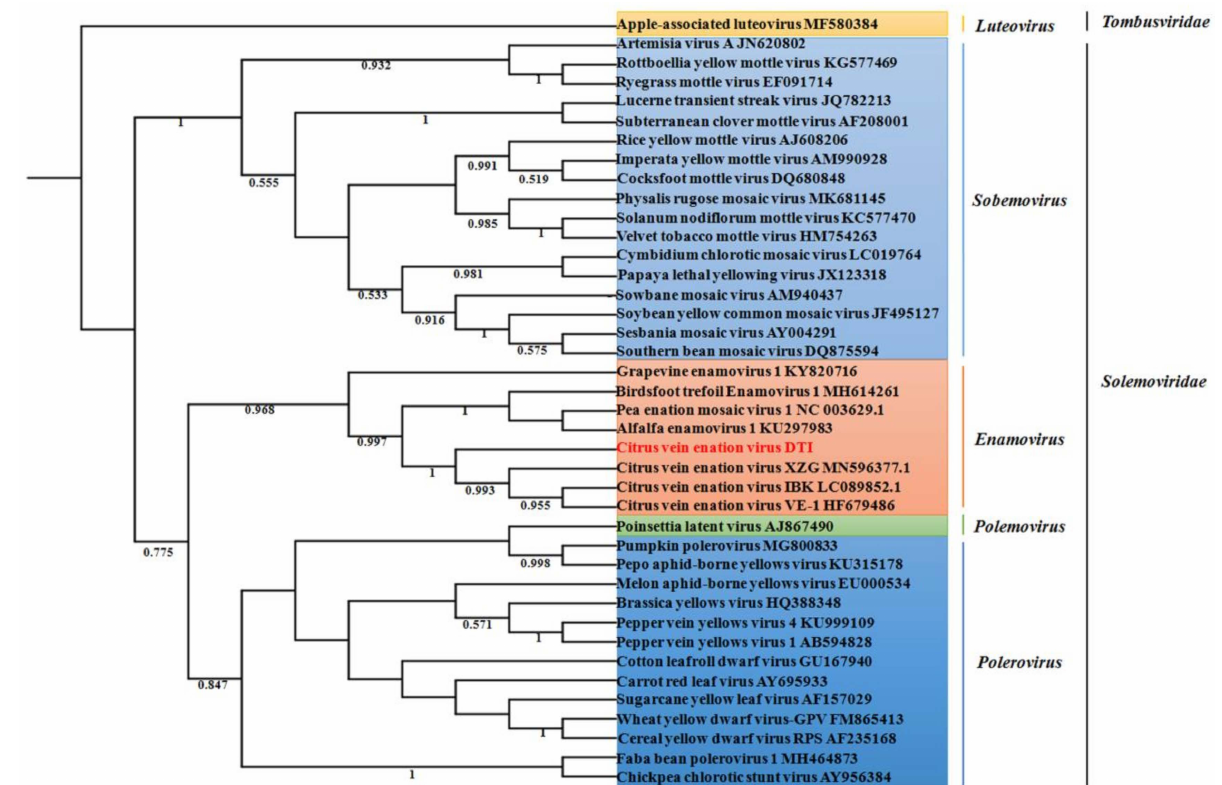
Figure 2. Phylogenetic analysis of CVEV and selected solemoviruses based on amino acid sequences of RNA-directed RNA polymerase using the maximum likelihood method with a bootstrap test of 1000 replicates. Apple-associated luteovirus from the Luteovirus genus served as the